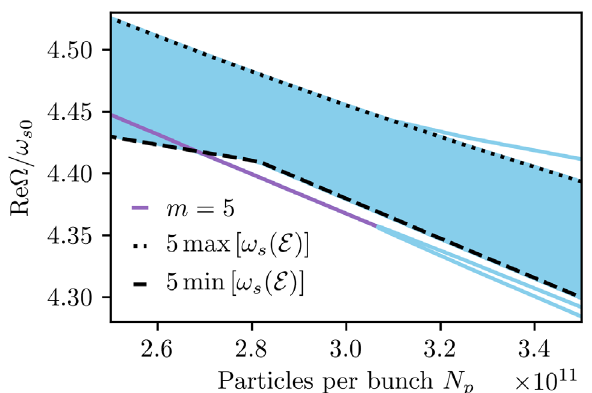
FIG. 6. Zoomed version of Fig. 4 (top plot). Blue lines represent van Kampen modes, while the unstable mode is shown in purple. The minimum and maximum incoherent synchrotron frequencies of the fifth azimuthal mode are plotted as dashed and dotted lines, respectively.